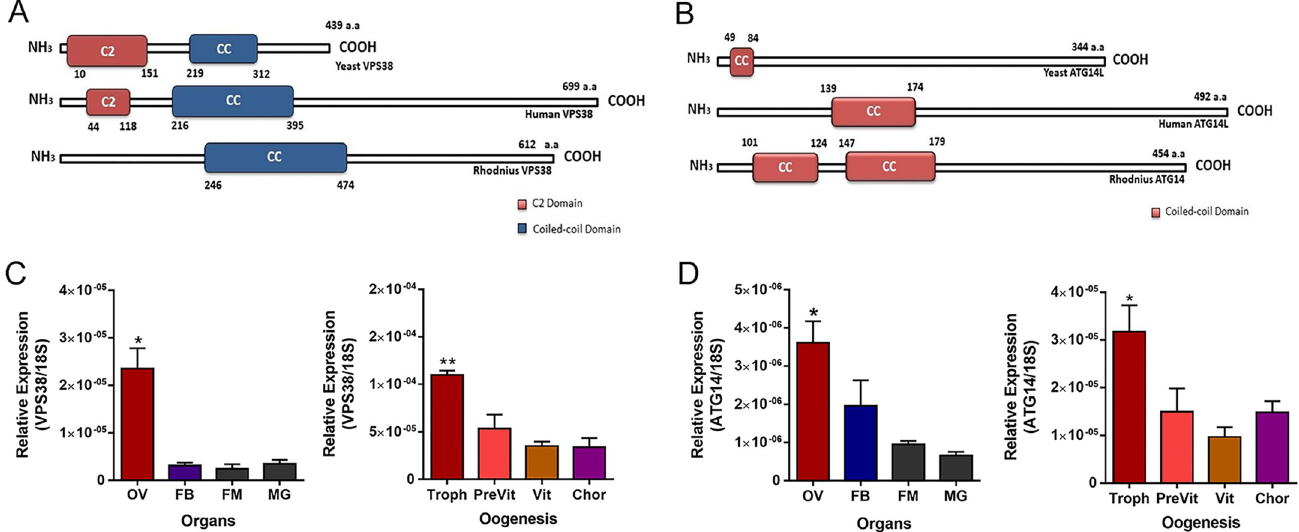
Fig 1. VPS38/UVRAG and ATG14 are conserved and highly expressed in the ovaries. A-B. Diagram of the predicted conserved functional domains of human, yeast and Rhodnius prolixus VPS38/UVRAG and ATG4. C2, a protein structural domain involved in targeting PI3K to the cell membrane, CC, coiled coil domain. C-D. RT-qPCR showing the relative expression of VPS38 and ATG4 in different organs and during oogenesis of vitellogenic females. MG, Midgut; FB, Fat body; FM, flight muscle; Ov, Ovary. Troph, tropharium; PreVit, pre-vitellogenic follicles; Vit, vitellogenic follicles; Chor, chorionated oocytes. The relative expression was quantified using the Δ CT method with Rp18S as endogenous control. Graphs show mean ± SEM (n = 6). � p < 0.05, �� p < 0.01, One Way ANOVA.